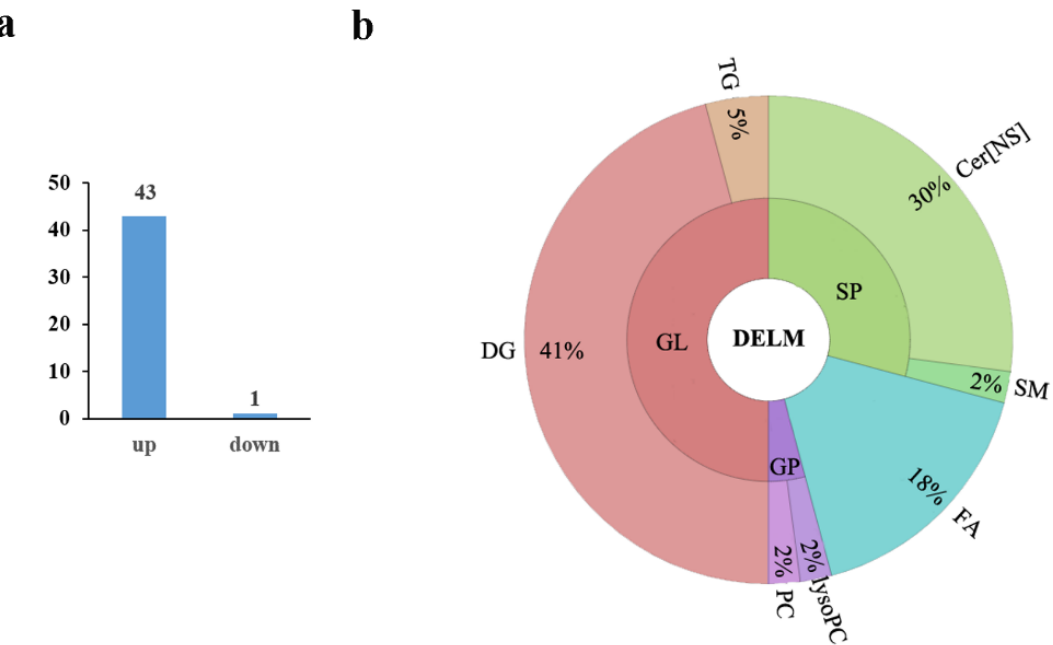
Figure 4. Differentially expressed lipid metabolites in the MSTN +/ − versus the WT pigs. ( a ) Of the 44 differentially expressed metabolites, 43 were upregulated and 1 was downregulated; ( b ) The differential metabolites included 24 glycerolipids (GL), 14 sphingolipids (SP), 8 fatty acyls (FA), and 2 glycerophospholipids (GP). There were 22 diacylglycerol (DG) and 2 triacylglycerol (TG) molecules in the 24 differentially expressed glycerolipids. There were 13 ceramide non-hydroxy fatty acid-sphingosine (Cer[NS]) and 1 sphingomyelin (SM) in differential sphingolipids.